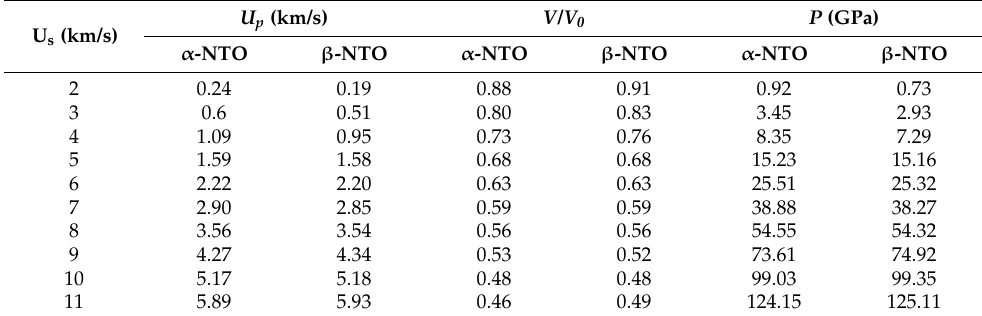
Table 2. The shock Hugoniot state of α -NTO and β -NTO.